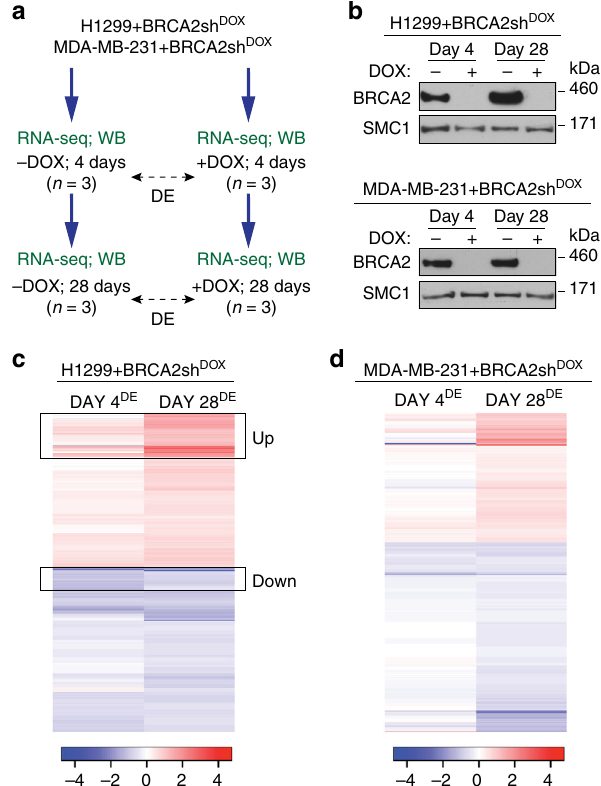
Fig. 1 Transcriptome changes during the transition from short-term (acute) to long-term (chronic) BRCA2 inactivation in human cells. a Human H1299 and MDA-MB-231 cells carrying a doxycycline (DOX)-inducible BRCA2 shRNA were grown in the presence or absence of 2 µ g/mL DOX for 4 or 28 days before processing for RNA-seq and western blot analyses.